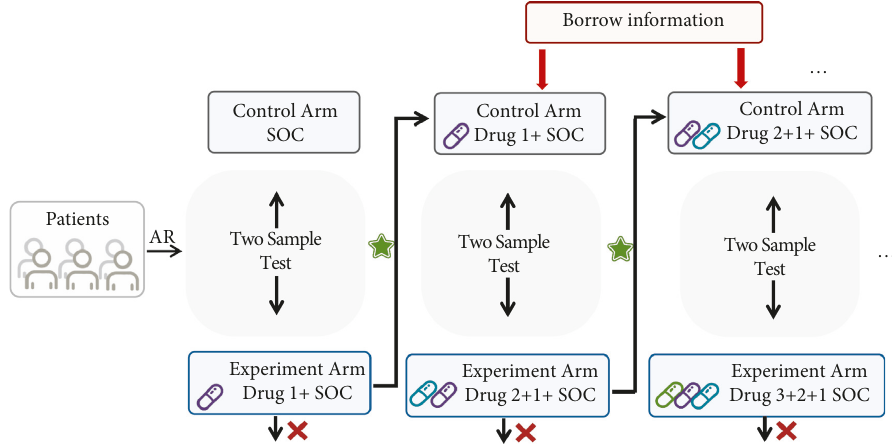
Figure 1: Diagram of platform design for